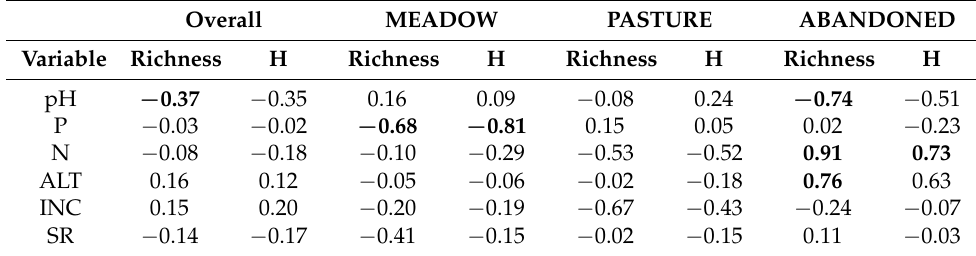
Table 2. Spearman correlation coefficients among environmental variables and plant species richness and Shannon diversity (H) assessed at all sites (overall) and separately for each management type. Statistically significant correlations (at p < 0.05) are highlighted in bold. For abbreviations see Table 1. Overall MEADOW PASTURE ABANDONED Variable Richness